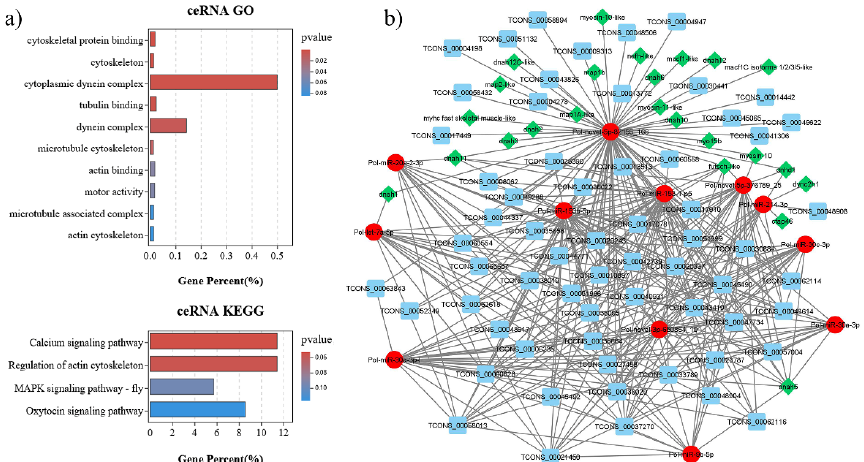
Figure 4. The mRNA–miRNA–lncRNA interaction with sperm motility-related pathways in gyno- genetic P. olivaceus . ( a ) GO and KEGG enrichment of DEmRNAs from the ceRNA network; ( b ) ceRNA sub-network with cytoskeleton and microtubule-related DEmRNAs. Green diamonds represent DEmRNAs, blue boxes represent DElncRNAs and red circles represent DEmiRNAs.